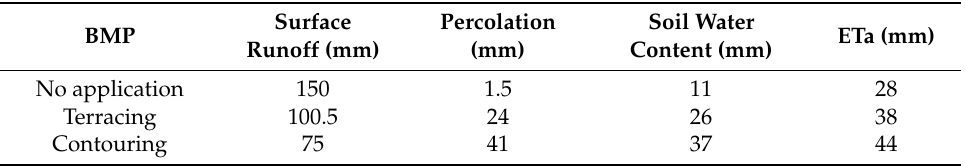
Table 3. The average water components (2006–2013) in Hydrological Response Units (HRUs) in dry farmlands with slope larger than